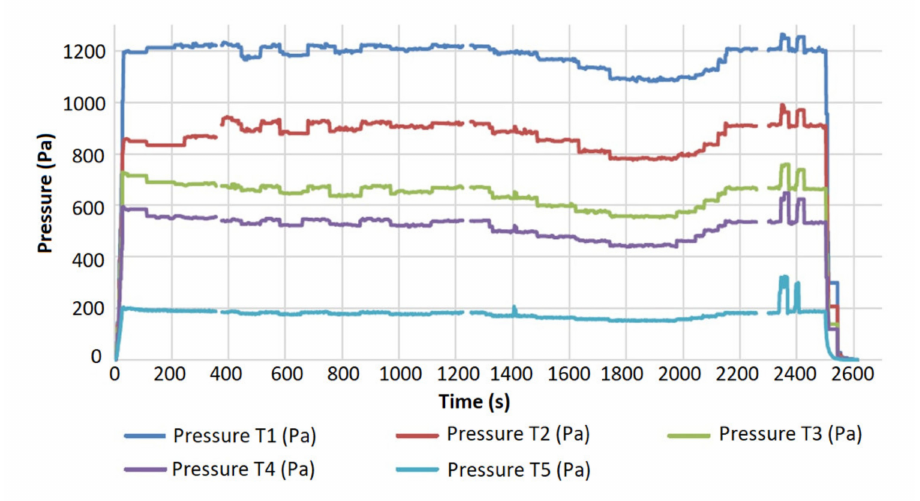
Figure 10. Measured static pressures during the first and second tests. Figure 11 shows the dynamic pressure waveforms from all the five measuring